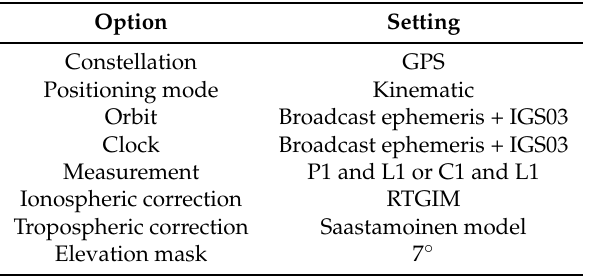
Table 5. Single-frequency precision point positioning settings.